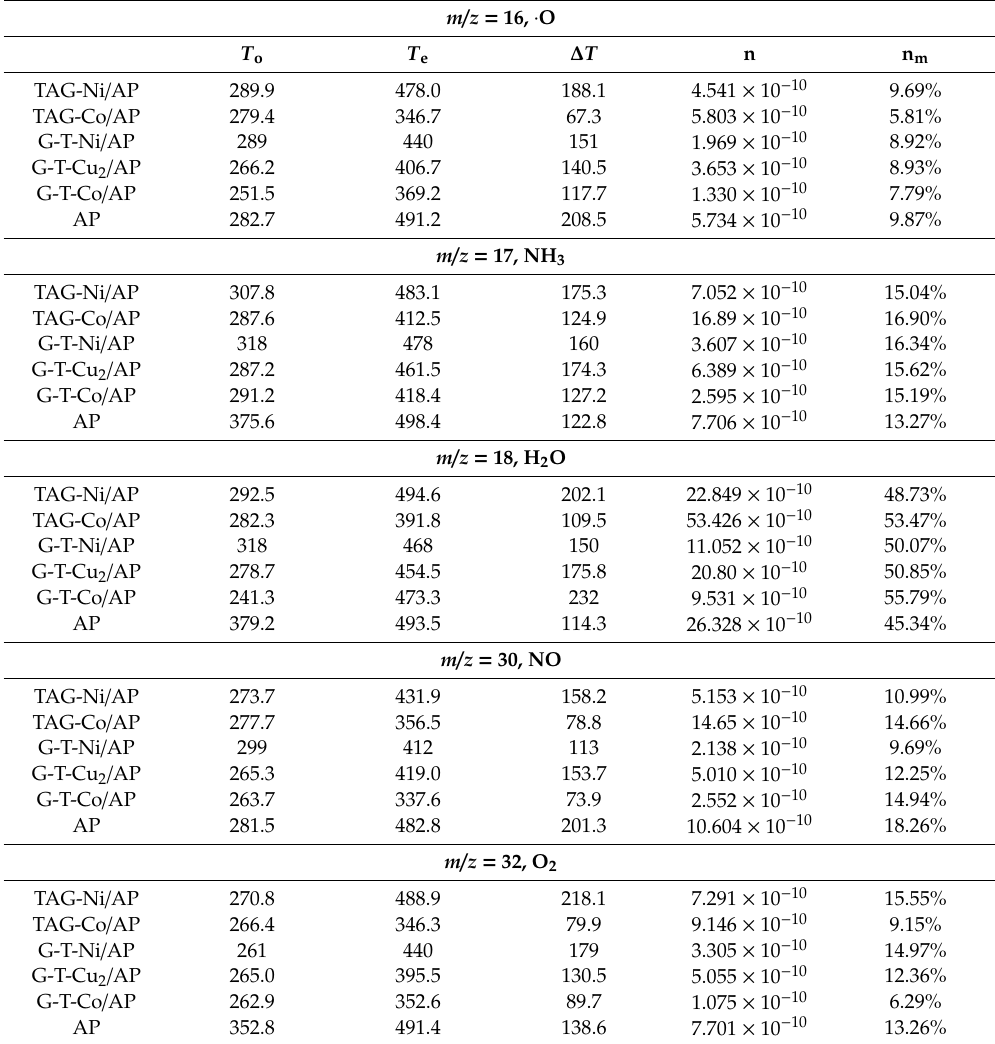
Table 2. A summary of TG / MS parameters of AP coated by different GO (graphene-oxide)-based